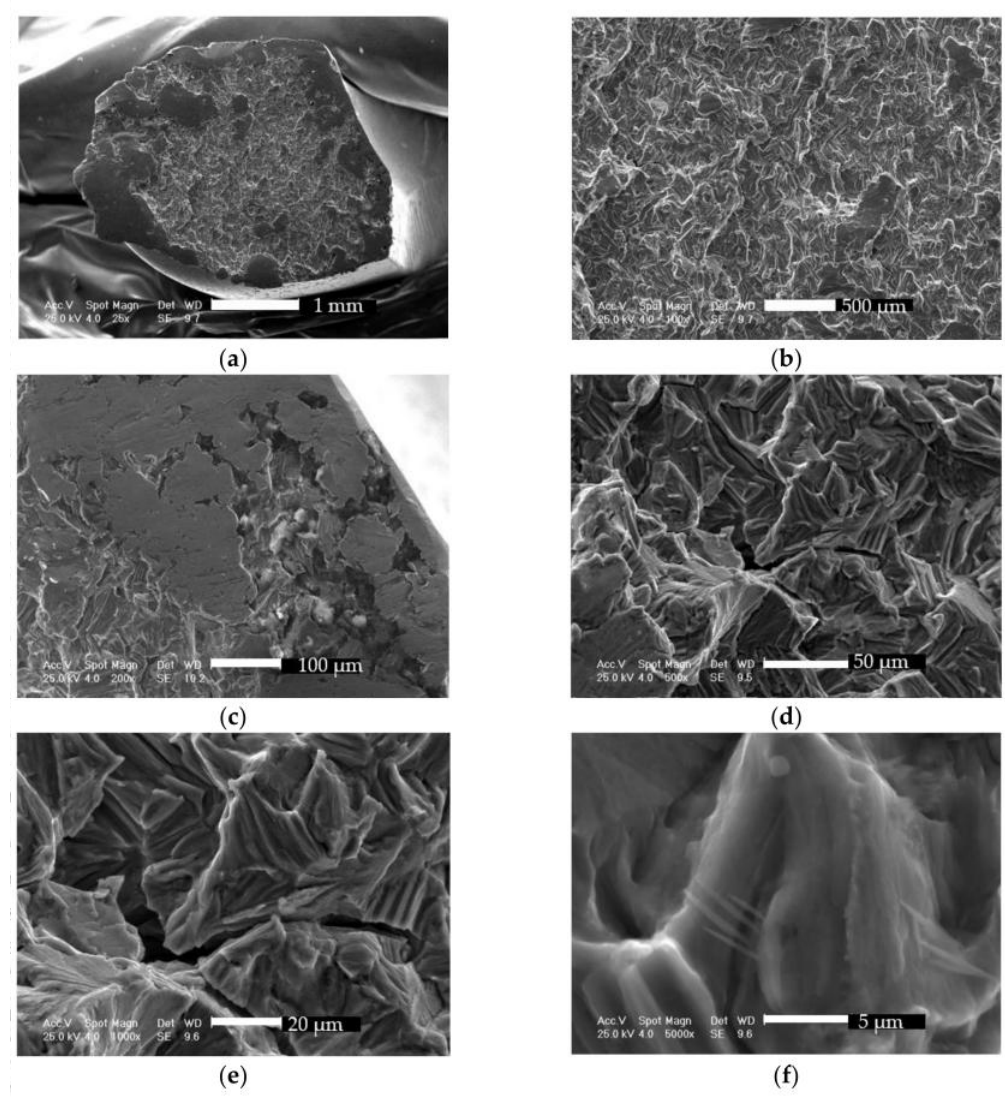
Figure 17. Scanning electron micrographs showing fracture morphology: ( a ) overall aspect of the fracture surface at 25 × ; ( b ) intercrystalline and transcrystalline fracture features at 100 × ; ( c ) sliding marks on galling features at 200 × ; ( d ) intercrystalline and transcrystalline fracture features at 500 × ; ( e ) fine cleavage steps on cleavage facets at 1000 × ; ( f ) fine cleavage steps on cleavage facets at 5000 ×